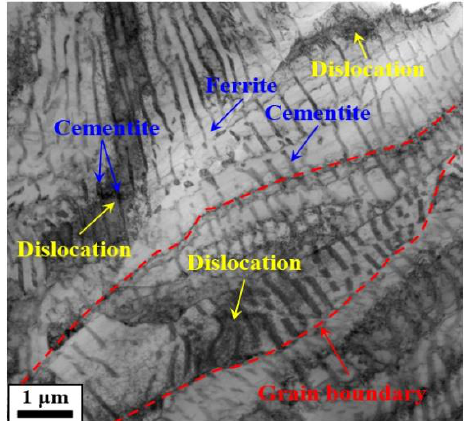
Figure 6. Microstructure characteristics on the extreme surface of the sample without LSP.